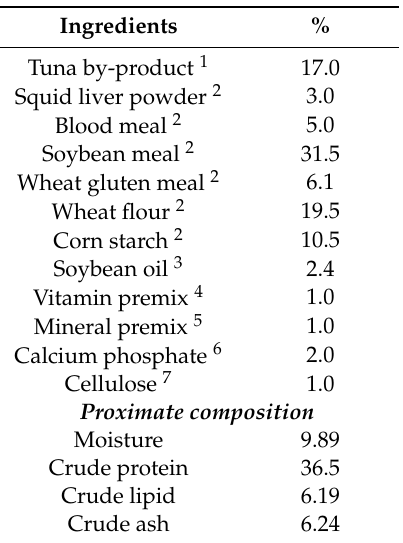
Table 1. Formulation and composition (% dry matter) of the basal diet for Nile